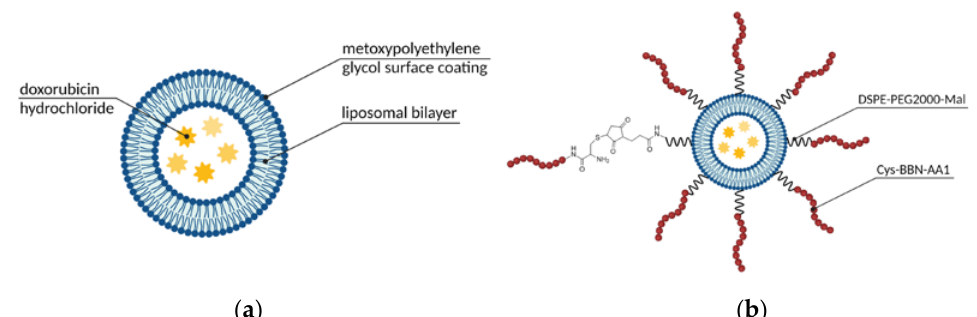
Figure 9. Structures of ( a ) Doxil (PEGylated liposomal doxorubicin) (inspired by ref. [83]) and ( b ) Doxil conjugated with BBN employing DSPE-PEG2000-maleimide (inspired by ref. [39]). Created with BioRender.com.